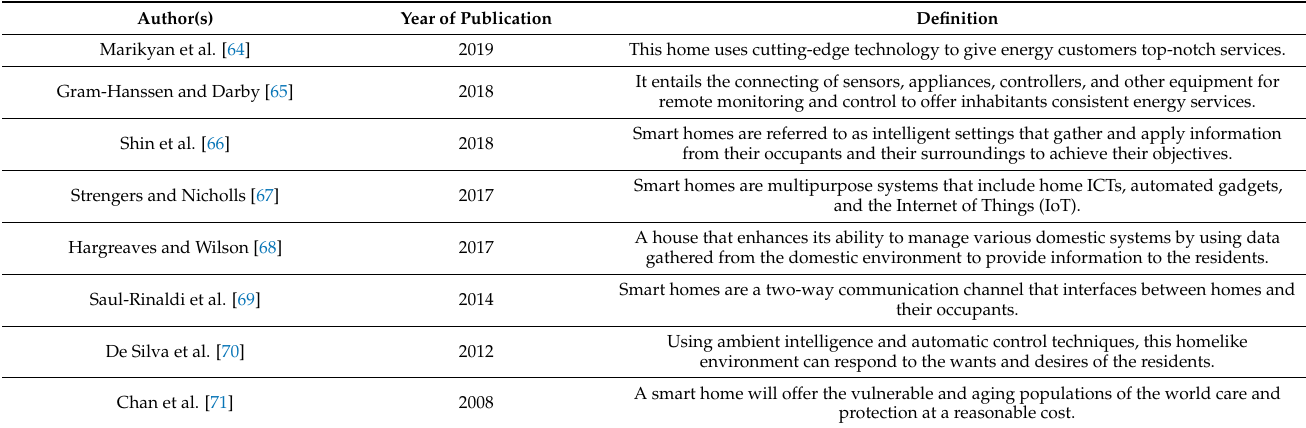
Table 2. Definition of smart homes/buildings by some